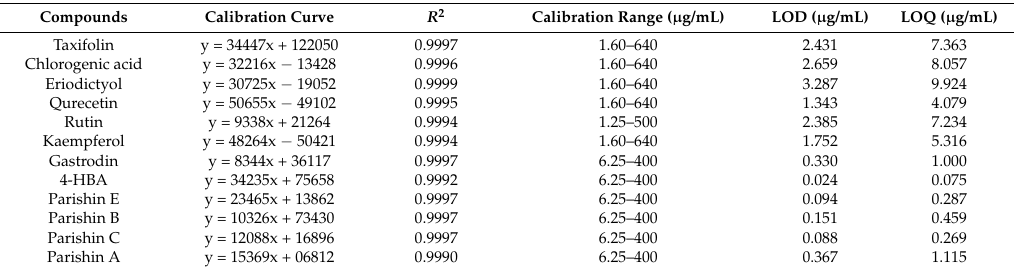
Table 3. Validation data for the representative standards used to quantify polyphenols in fully mature M. tricuspidata fruit using HPLC-DAD (220 nm).